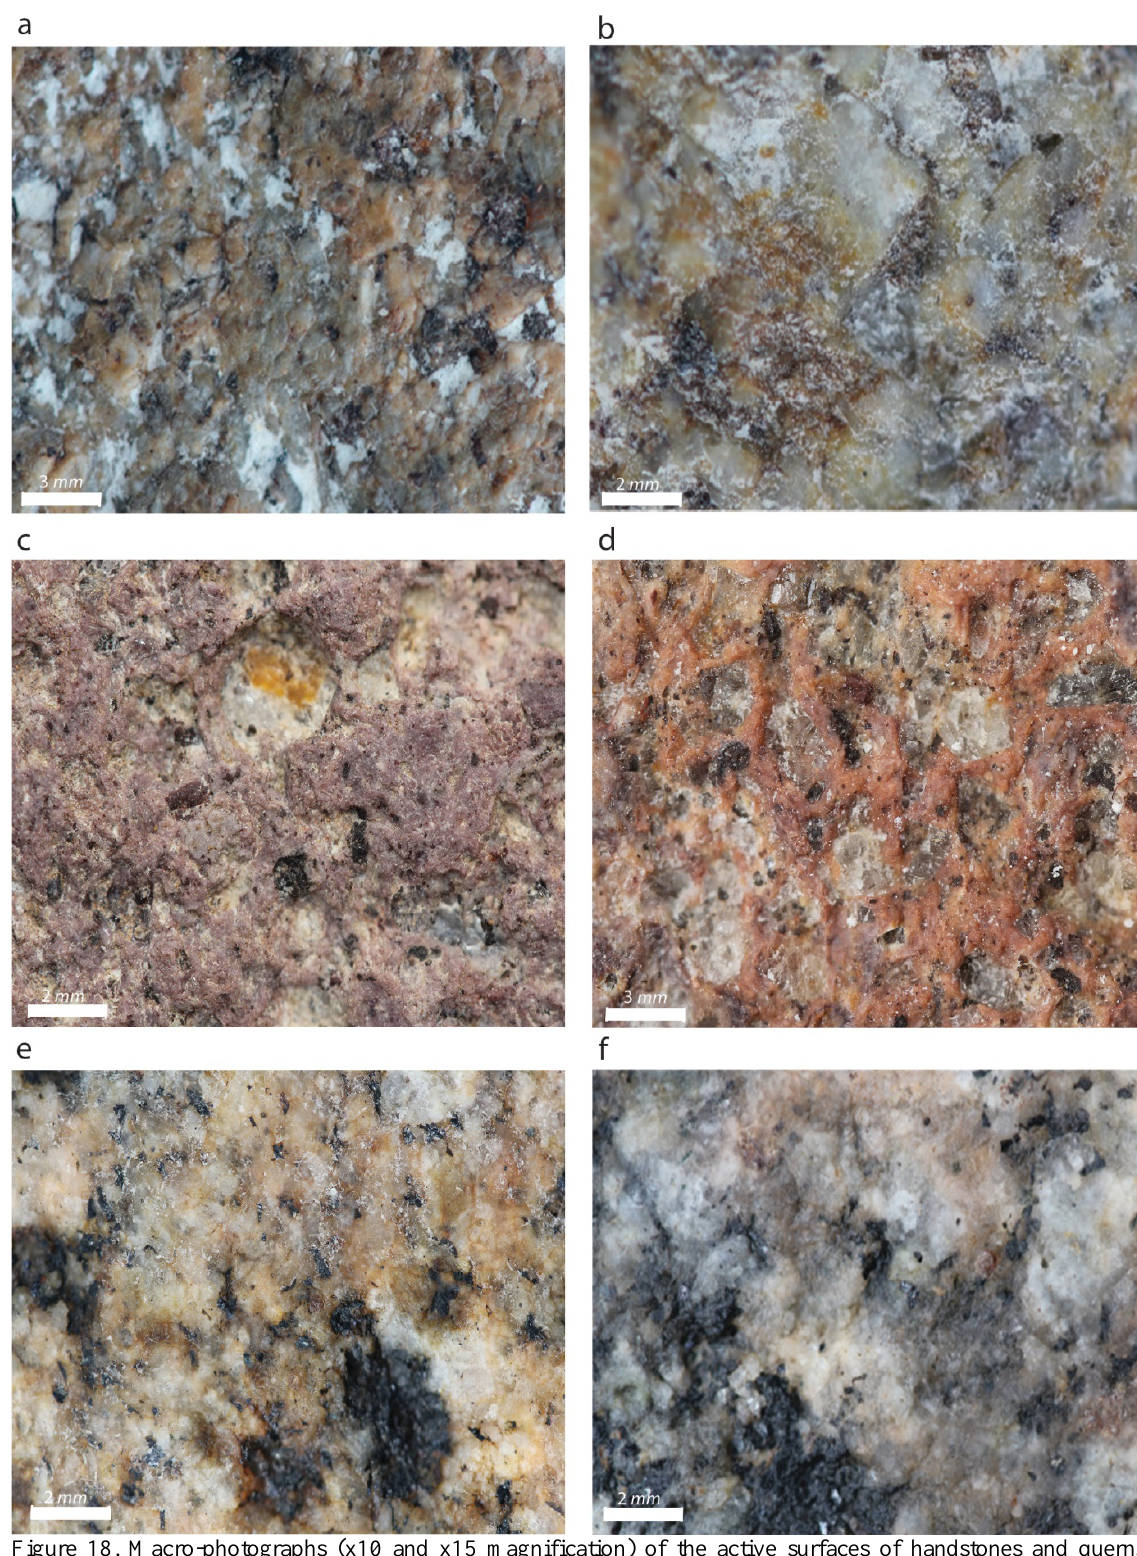
Figure 18. Macro-photographs (x10 and x15 magnification) of the active surfaces of handstones and querns showing different use-wear. a) Milling wheat (surface of a handstone). Flour is still visible in the interstices. b) Milling wheat (surface of a quern). Flour is still visible in the interstices. c) Milling dry sorghum (surface of a quern). Only the high topography is affected in this picture. d) Crushing fresh sorghum (surface of a quern). Fracture and extraction of grain. e) Crushing corn and sorghum (active surface from the back of a handstone, last used for crushing corn). f) Manipulation (surface of the back of a handstone). Use for milling cereals. (Scale bars. a. 3 mm, b. 2 mm, c. 2 mm, d. 3 mm, e. 2 mm, f. 2